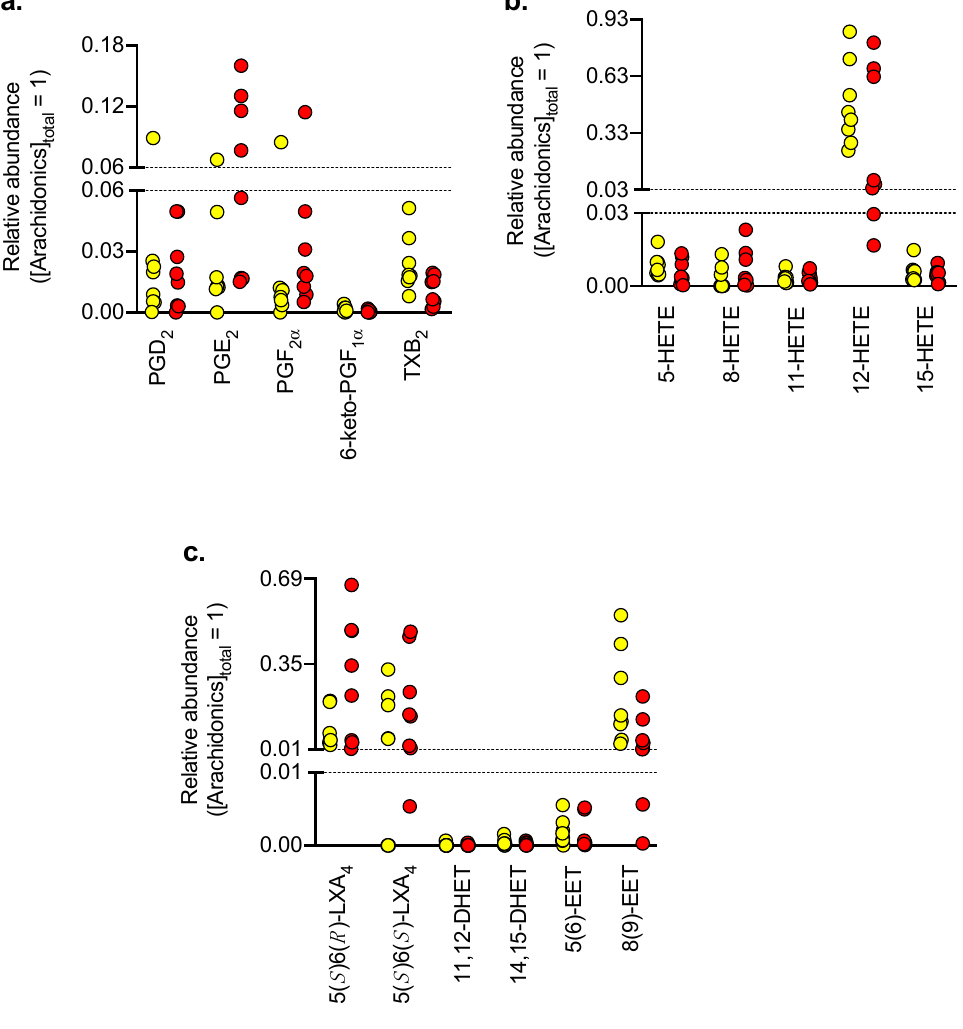
Figure 4. Composition of arachidonic acid-derived oxylipins in control (yellow) and OLP tissue (red) biopsies. The panels show fractional contents: ( a ) prostaglandins, ( b ) HETEs, and ( c ) other arachidonate derivatives, where the concentration of lipid/combined concentration of all sixteen oxylipins are shown for each individual case. Note the different scales on the y axis in the panel. Abbreviations (when not already explained): TXB 2 , thromboxane B 2 ; DHET, dihydroxyeicosatetraenoic acid; EET, epoxyeicosatrienoic acid.